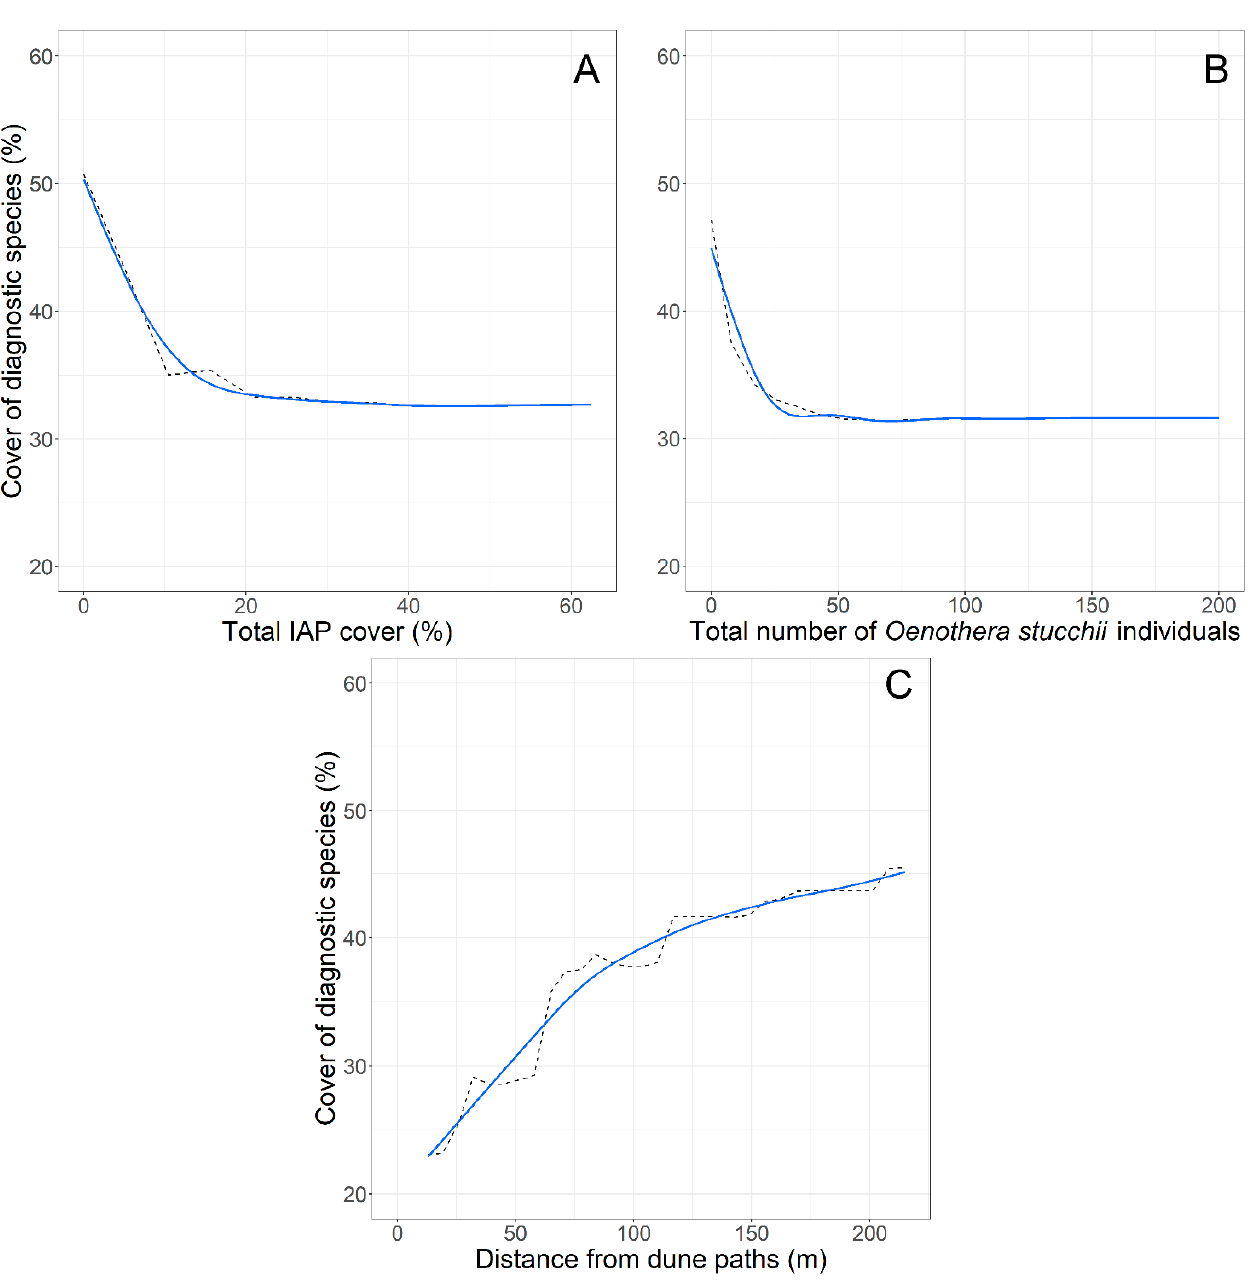
Figure 3. Dependence Plots (PDP) for the three most important covariates in RF (Random Forest) model for shifting dunes (( A ): Total IAP cover and ( B ): Oenothera stucchii individuals) and for transition dunes (( C ): Distance from dune paths). The blue line represents a smoother (general additive model) to enhance visualization of the general trend, shown as dotted black line.